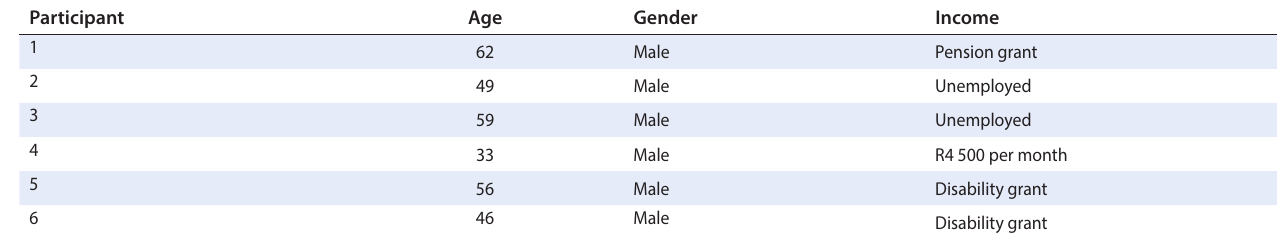
Table 3: Focus group interview